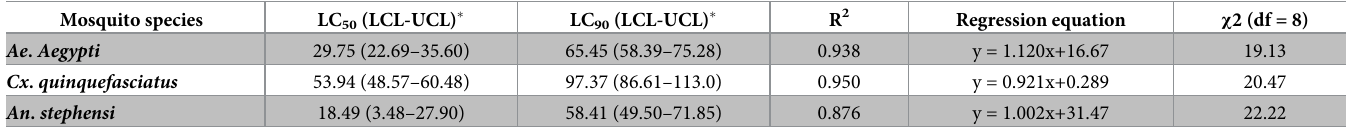
Table 5. Lethal concentrations, R 2 , Regression equations and χ 2 values for pupicidal activity of AgNPs synthesized by Bacillus marisflavi against the pupae of Ae . aegypti , Cx . quinquefasciatus and An . stephensi .